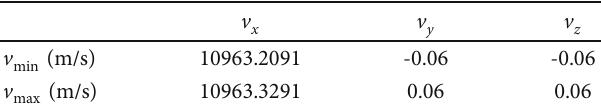
Table 5: The range of velocity of the TLI